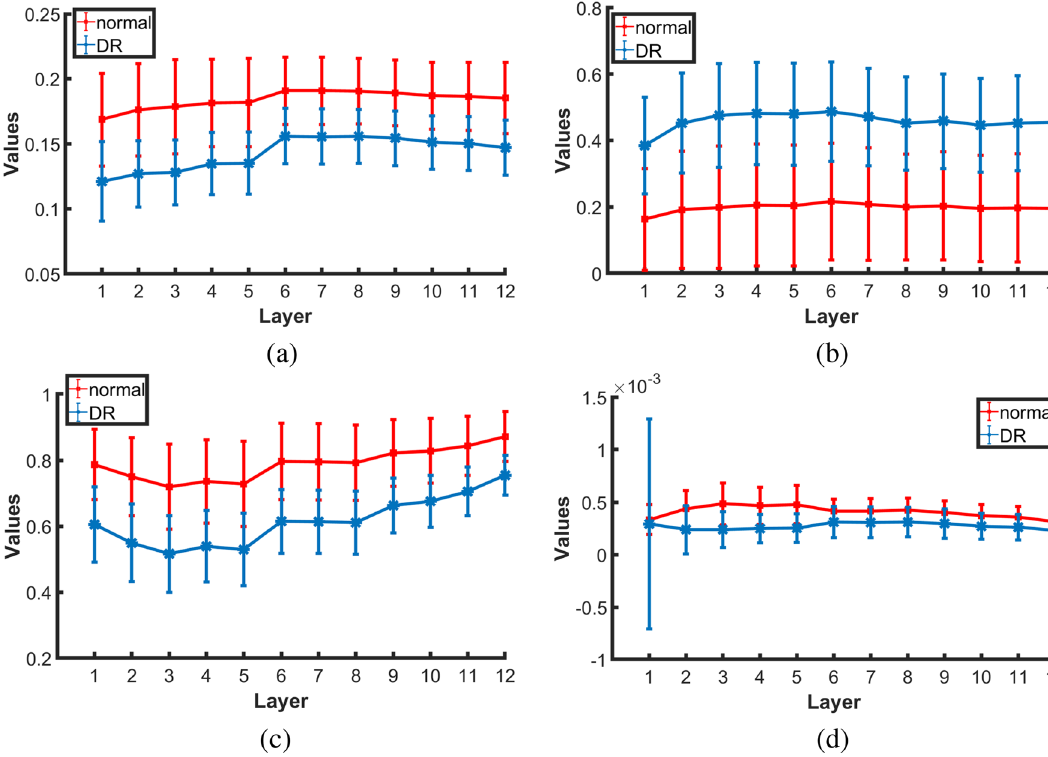
Figure 7. Average and standard deviation of the extracted GLCM features: ( a ) homogeneity, ( b ) contrast, ( c ) correlation, and ( d ) energy for all normal and DR cases at the twelve